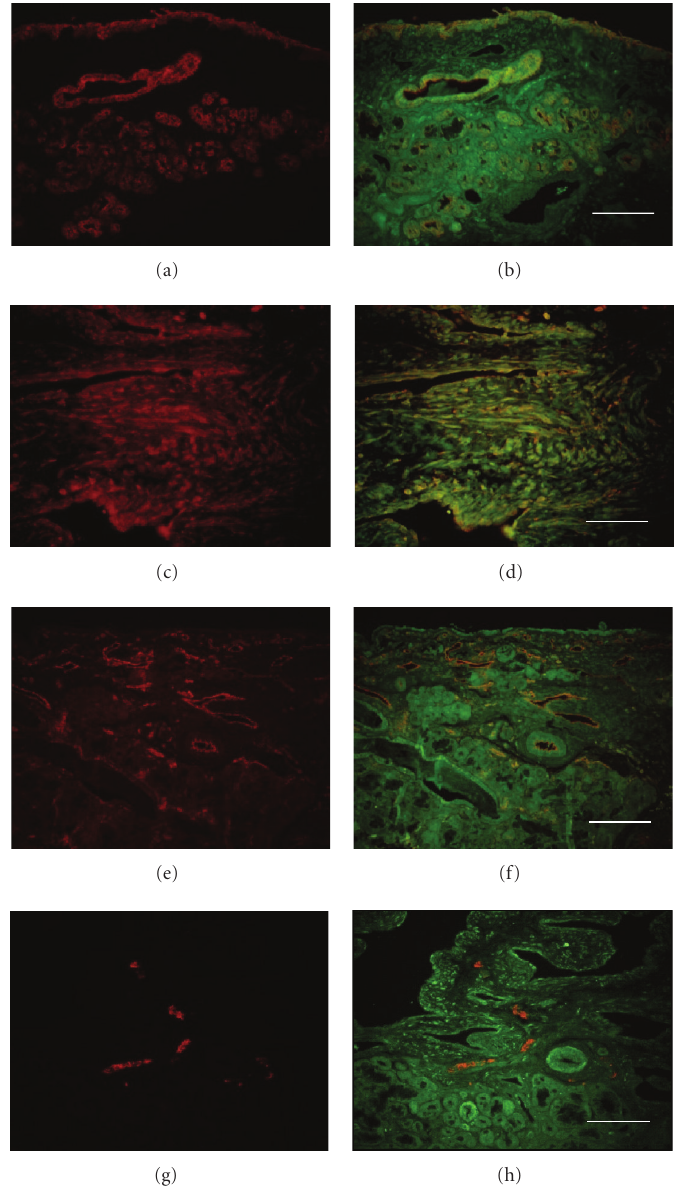
Figure 3: Identification of subsets of cells expressing the B1 receptor in human allergic nasal mucosa. Single staining immunofluorescence for each cell type (panel (a), (c), (e), and (g) and the dual staining for the cell marker and B1 receptor (panel (b), (d), (f), and (h). The B1 receptor protein (green) shows colocalization with antiphenotypical marker antibody (red) and the combined signal is visualized as yellow. Identification markers for cytokeratin (epithelial cells) (a), (b); fibroblast (c), (d); CD31 (vascular endothelial cells) (e), (f); neurofilament protein (peripheral nerves) (g), (h). Scale bar = 100 μ